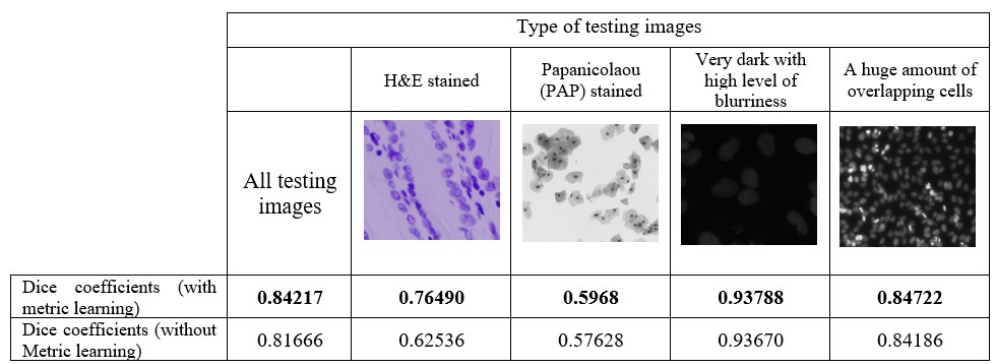
Figure 2. Dice coefficients estimated for one fold of testing samples based on the image type.